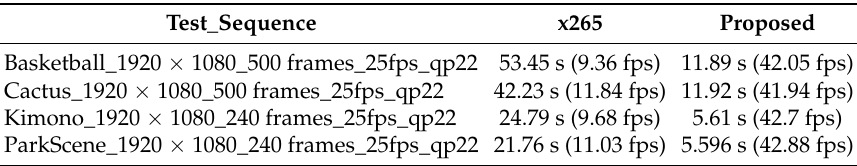
Table 4. The 2D transcoding comparison.